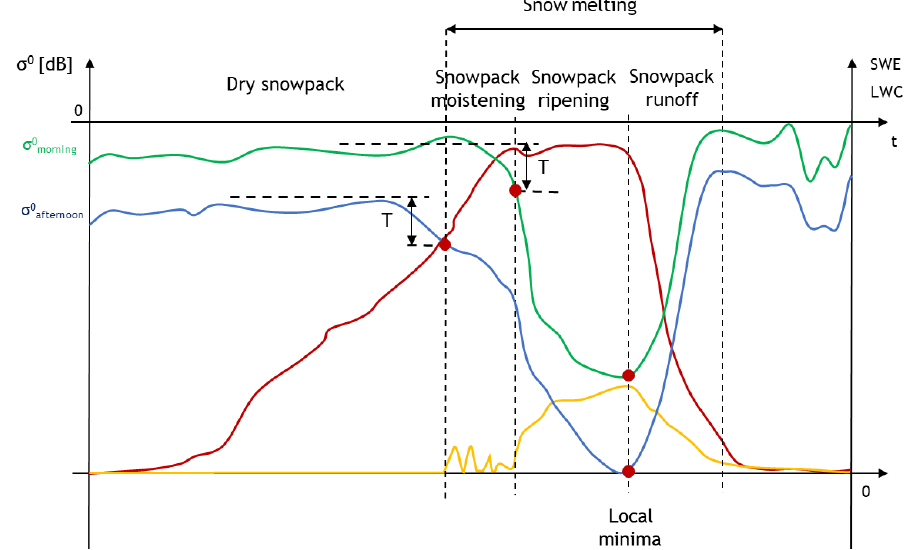
Figure 5. Schematic representation of the evolution of the backscattering coefficient acquired in the morning (green line) and in the afternoon (blue line) compared with LWC (yellow line) and SWE (red line) evolution. The offset between the morning and afternoon signals is due to the generally different local incidence angle of the ascending and descending acquisitions in mountainous regions. The three melting phases are identified from the LWC and SWE information. Correspondingly, the rules for the identification of each phase from the time series of σ 0 are highlighted: a decrease of at least T (dB) from the mean value in dry snow conditions applied to the afternoon and morning signals identifies the moistening and ripening onsets respectively. The local minima of the signals indicate the runoff